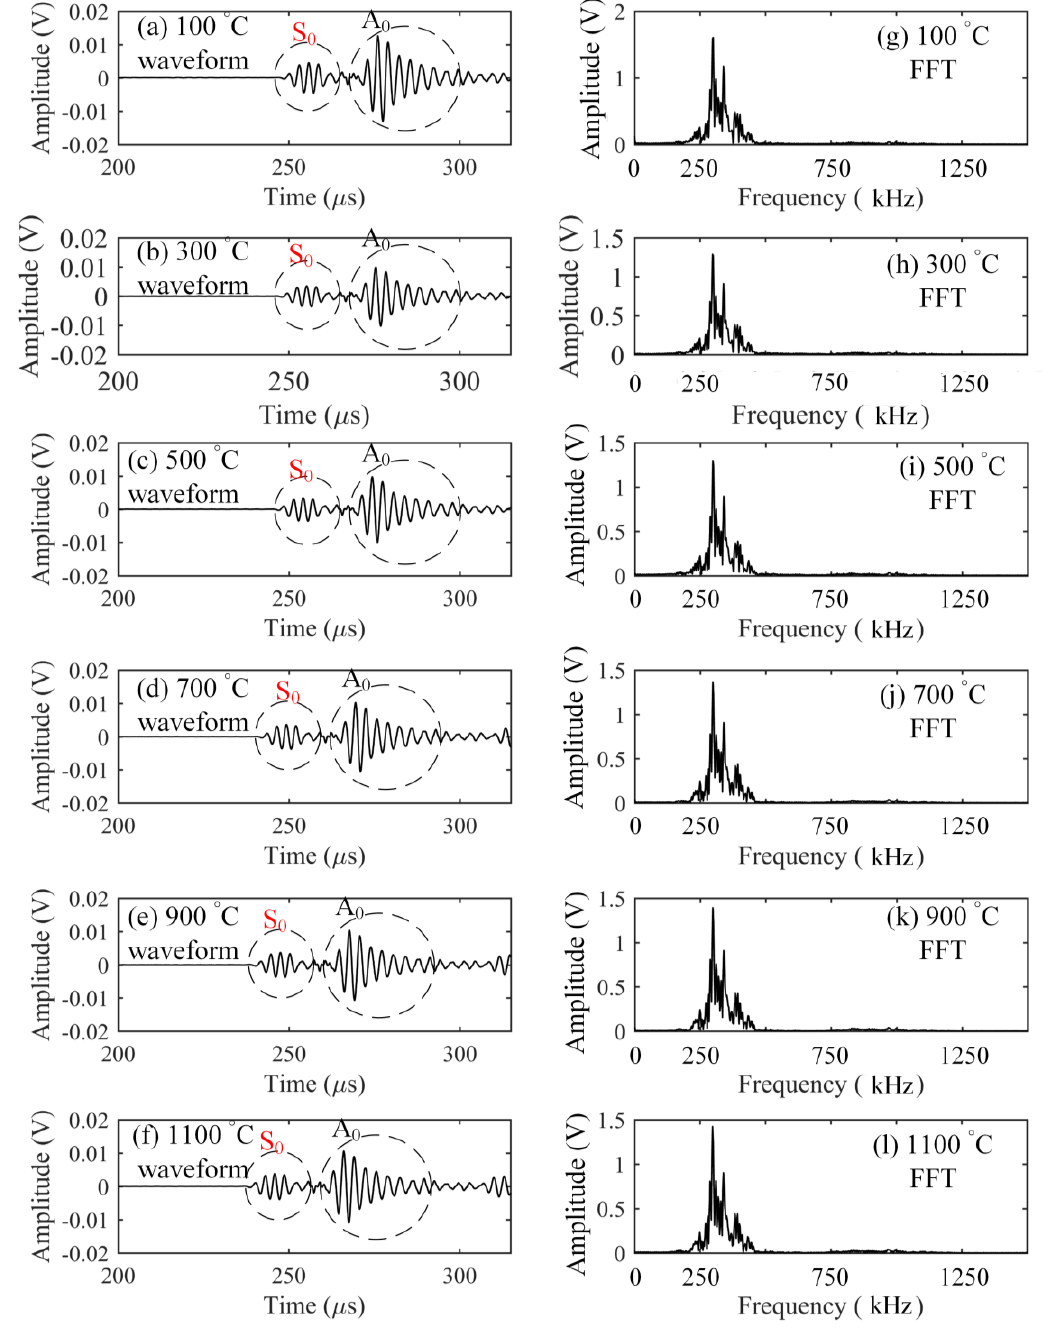
Figure 4. Responses to an ultrasonic wave with a center frequency of 300 kHz.